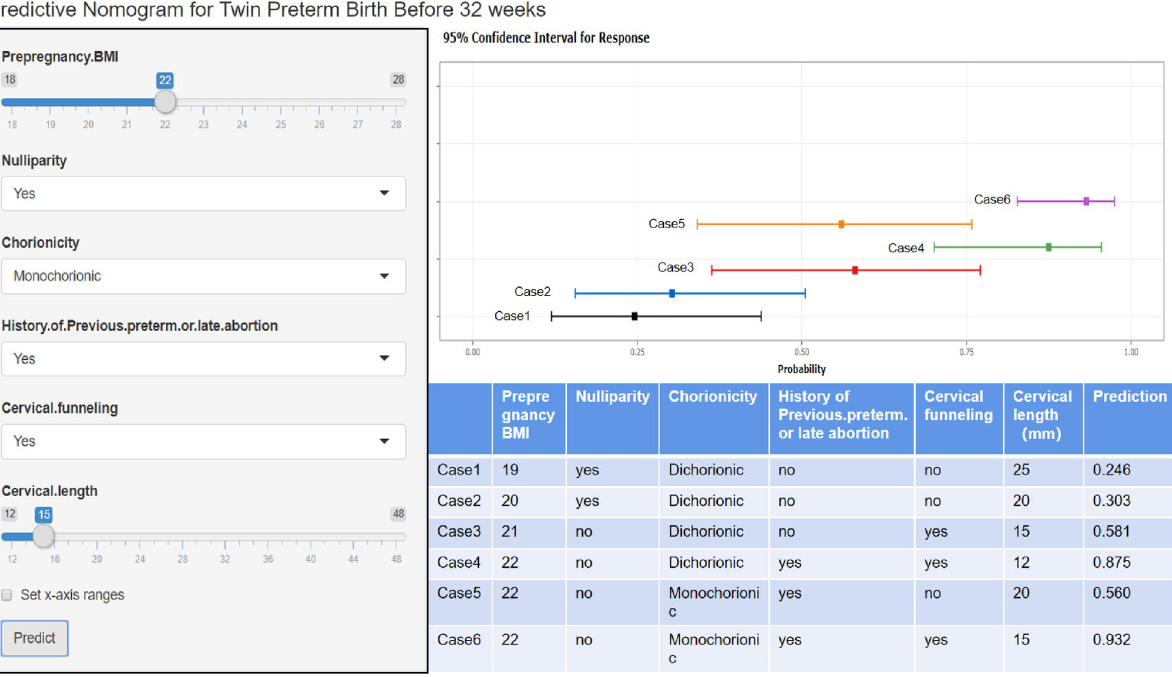
Figure 4. Screenshot of the online user-friendly model (https:// zhanw enqia ng. shiny apps. io/ DynNo mapp/) for the prediction of PTB. The users enter variables in the application tool on the left, and then the corresponding predicted probabilities and 95% confidence intervals (CIs) are displayed in the right figure. The table at the bottom right shows six examples of input variables and corresponding predicted